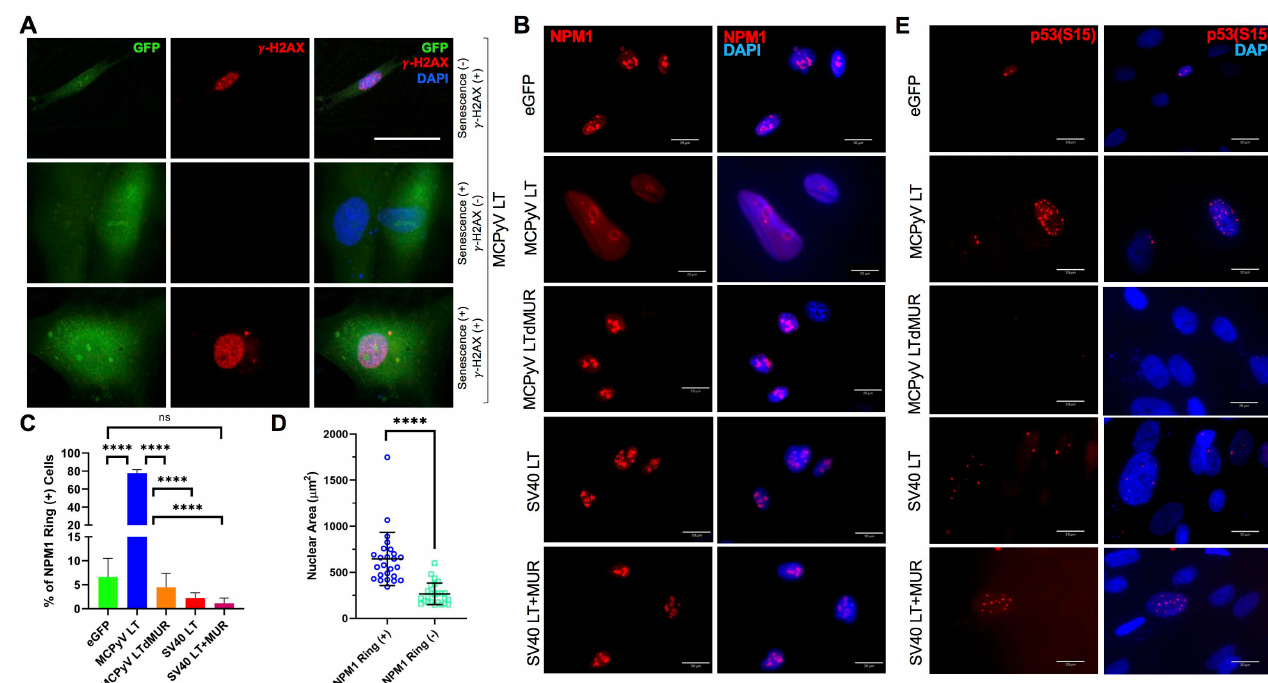
Figure 2. MCPyV LT induces a nucleolar stress response (NSR). ( A ) MCPyV LT − induced senescence is DDR-independent. Immunofluorescent staining for γ − H2AX, a DNA damage marker, in senes- cent (GFP + , nuclear size > 500 µ m 2 ) and non − senescent (GFP + , nuclear size = ~200 µ m 2 ) MCPyV LT − positive BJ − hTERT cells. Scale bar = 60 µ m. ( B ) MCPyV LT reorganizes the nucleolus. MCPyV LT induced a ring − like perinucleolar distribution of NPM1 within the nucleolus, a characteristic of canonical NSR. Immunofluorescent analysis of NPM1 is shown (red). Scale bars = 20 µ m. ( C ) MCPyV LT uniquely alters NPM1 structure. The percentage of NPM1 nucleolar ring − positive cells for the empty vector and each LT construct was recorded. Statistical significance was determined using the one − way ANOVA test (**** p < 0.0001, ns = not significant). Standard error bars represent mean value with standard error, n = 30 cells with 3 replicates. ( D ) Cells with NPM1 reorganization induced by MCPyV LT display senescent phenotypes. Nuclear size ( µ m 2 ) of MCPyV LT − expressing cells with or without NPM1 nucleolar rings. Unpaired Student’s t -test (**** p < 0.0001, ns = not significant). Standard error bars represent mean value with standard deviation, n = 25 cells per condition with 3 replicates. ( E ) MCPyV LT expression triggers the NSR and induces p53 phosphorylation through the MUR. Phospho − p53 (S15) is detected in MCPyV LT − expressing